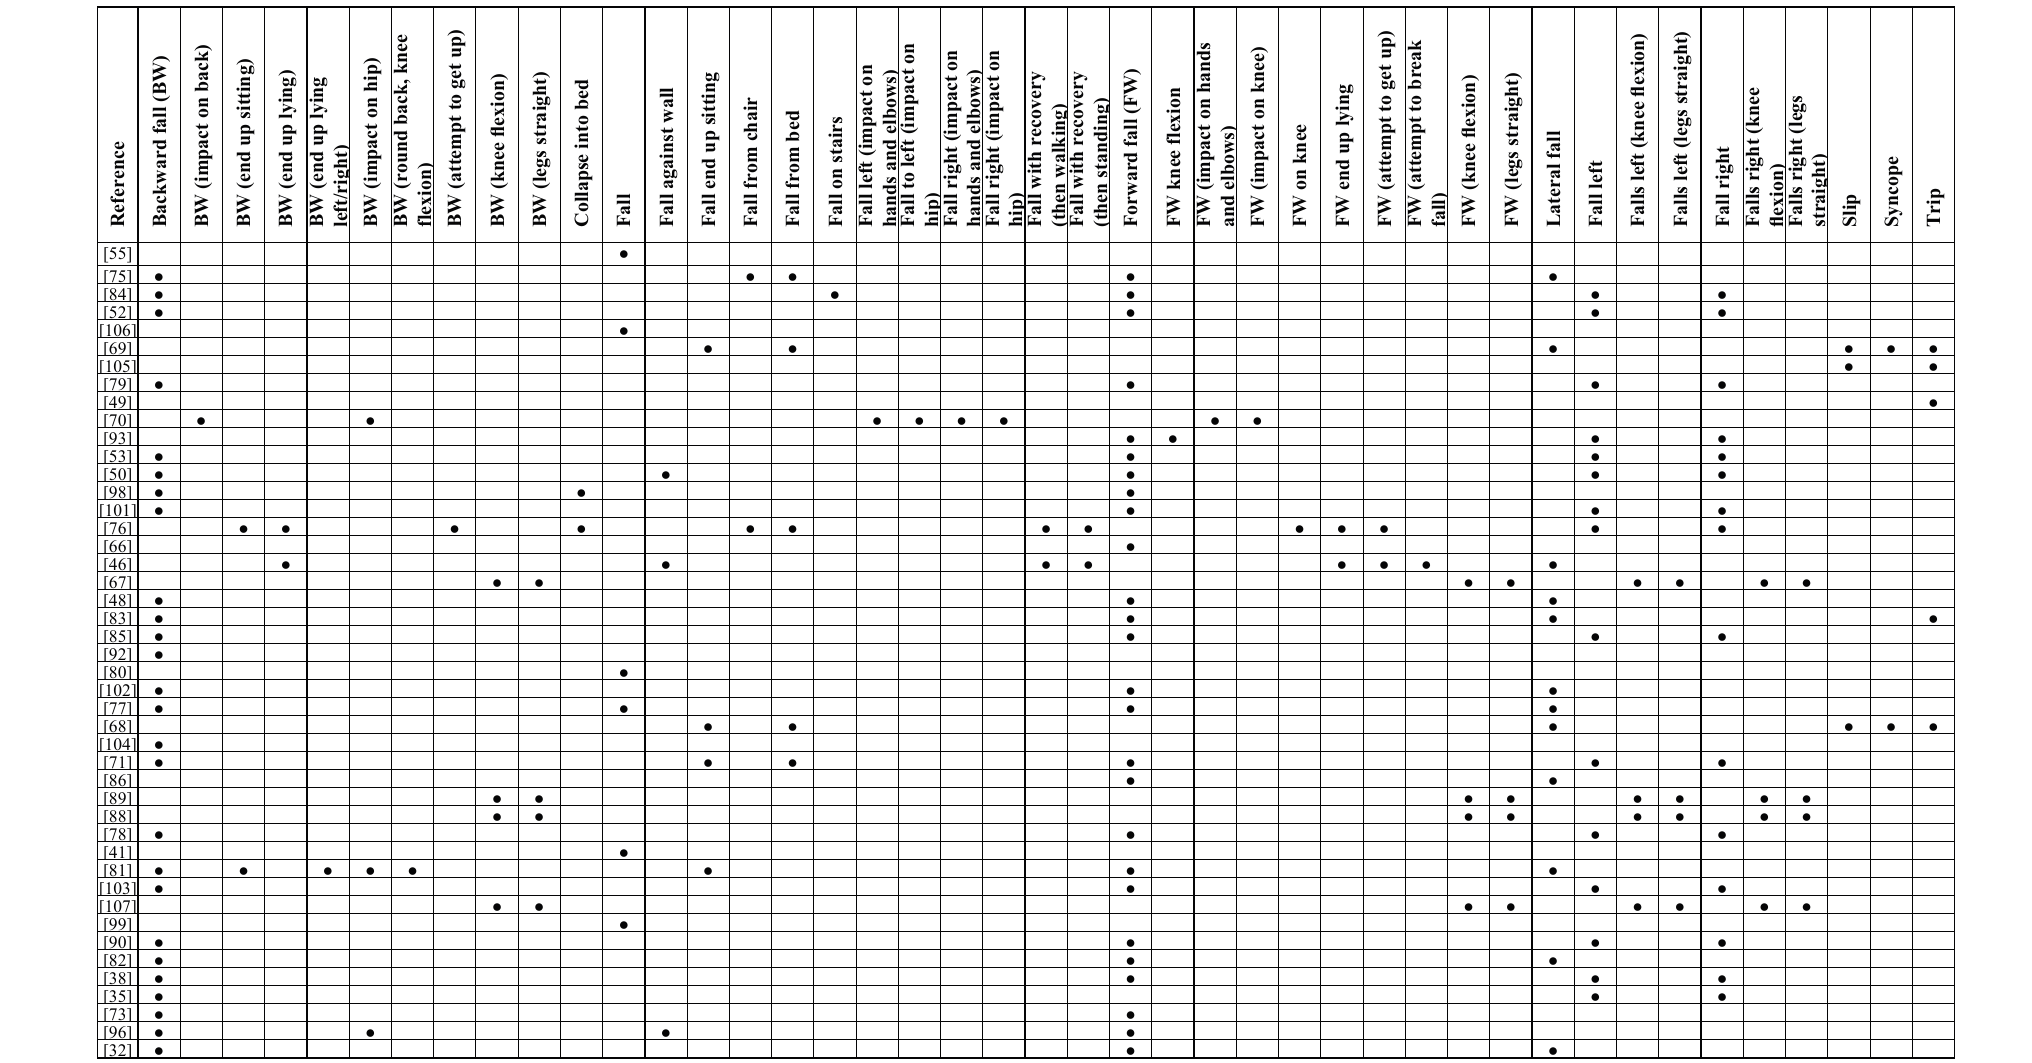
Table 3. Simulated fall